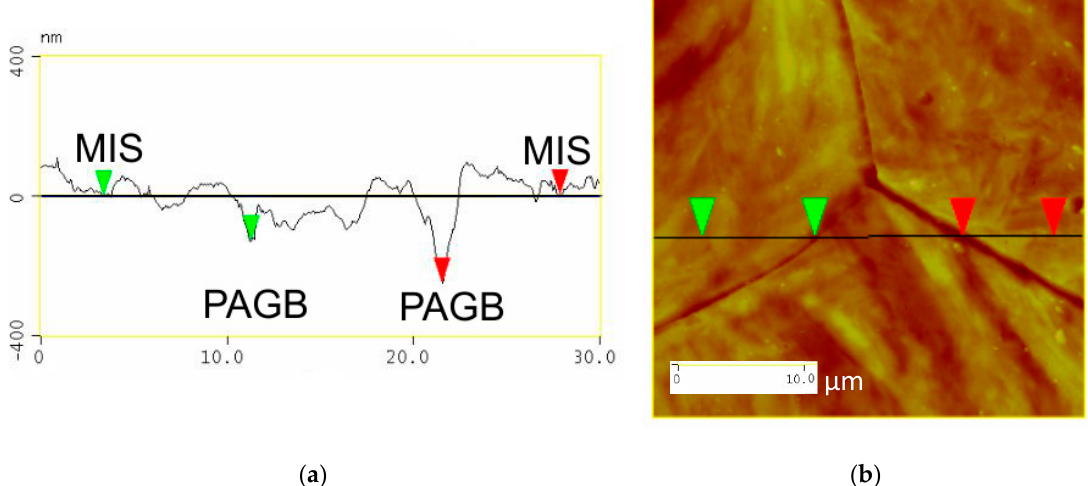
Figure 7. Surface analysis shown in ( a ) and the two-dimensional image shown in ( b ).